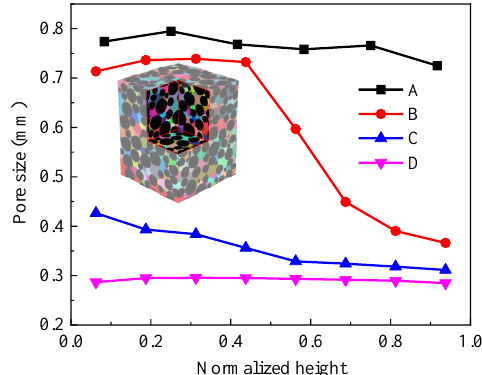
Fig. 6 Pore distribution with the compact height, the inset is the pore segmentation for compact A, the black color represents the